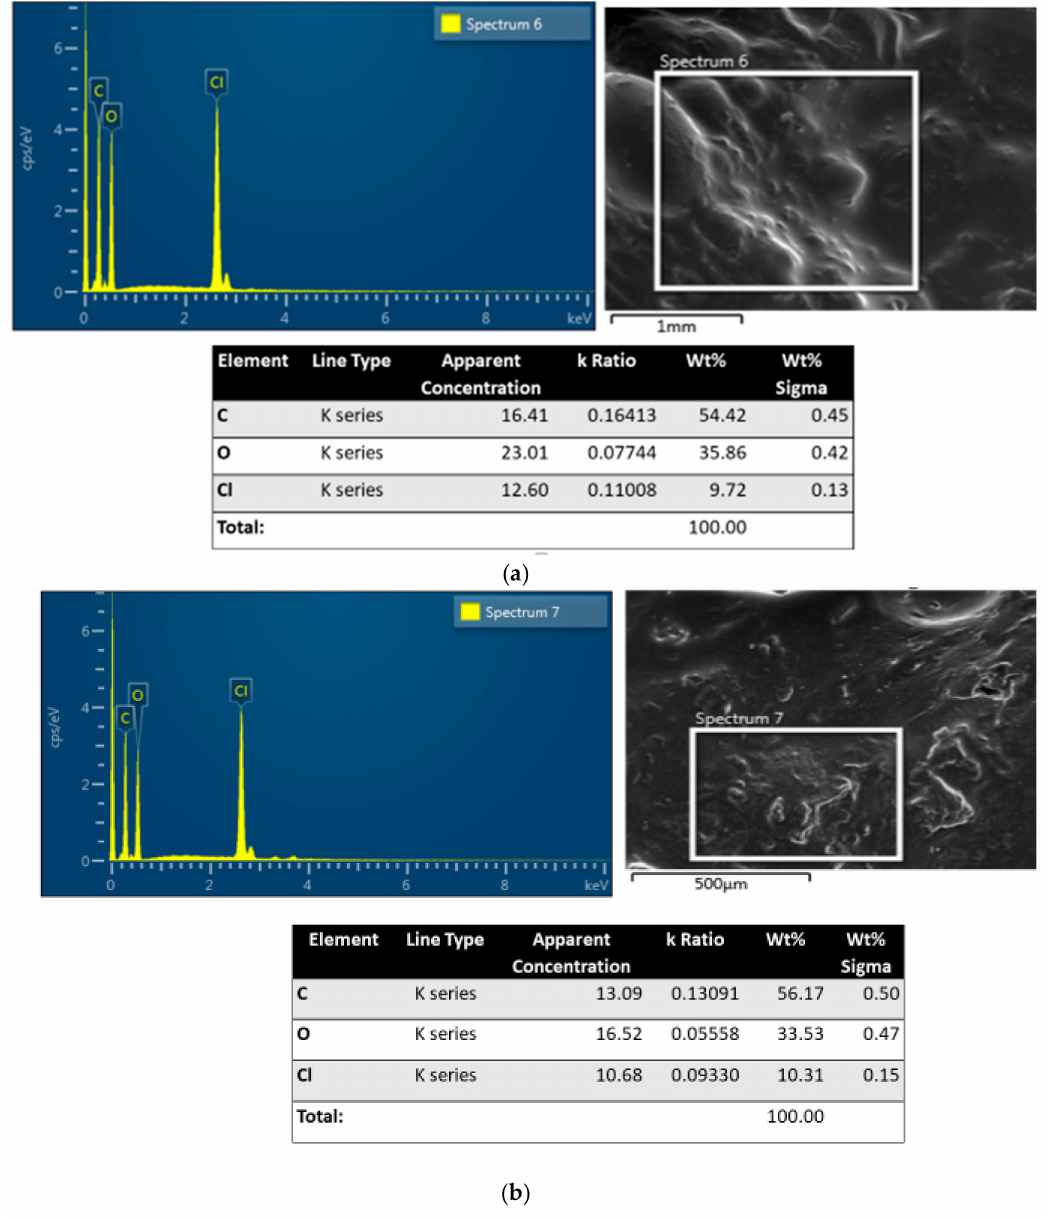
Figure 4. ( a ) Energy-dispersive X-ray spectroscopy (EDS) spectrum of pectin extracted by ChCl–Mal and its electron image with element composition; ( b ) EDS spectrum of pectin extracted by ChCl–Glc–W and its electron image with element